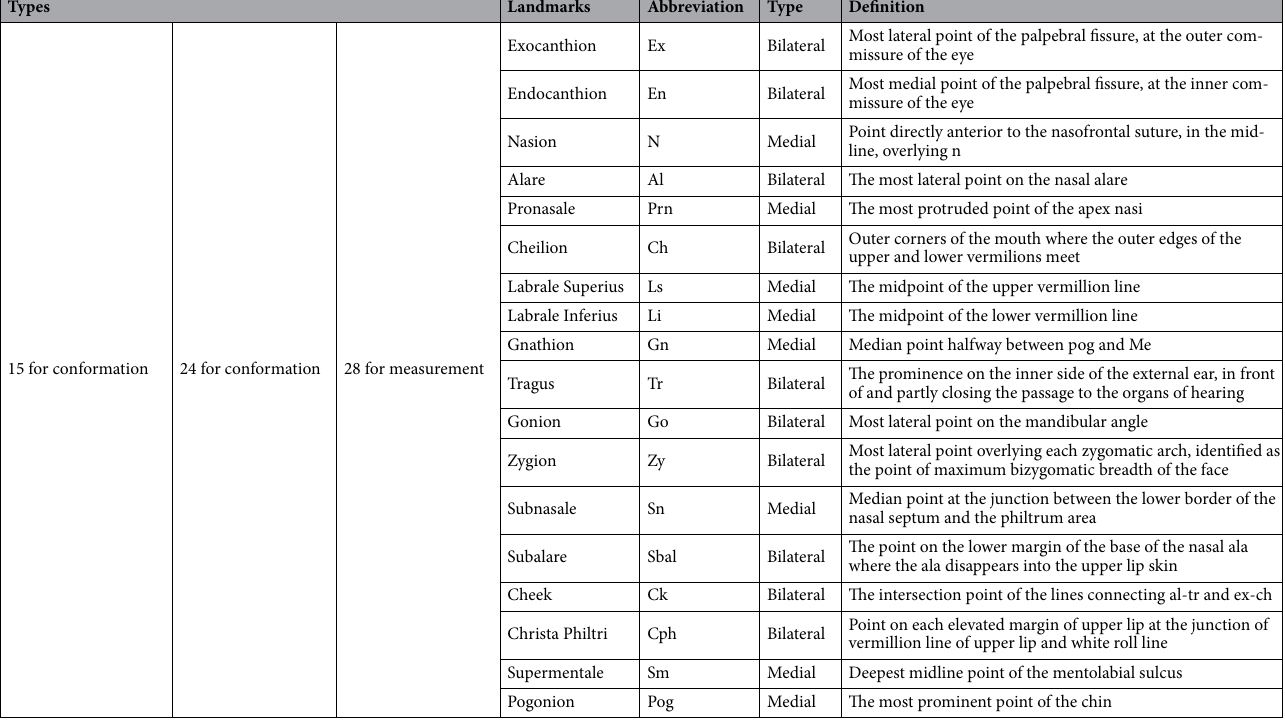
Table 1. The definition of registered landmarks for conformation and/or measurement.